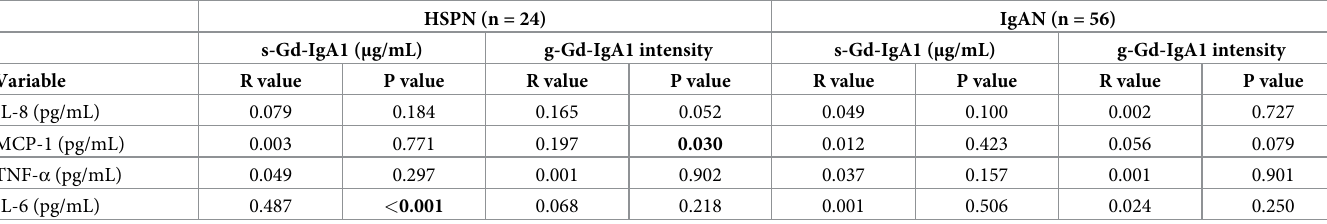
Table 4. Correlation between both types of Gd-IgA1 and inflammatory cytokines in patients with HSPN and